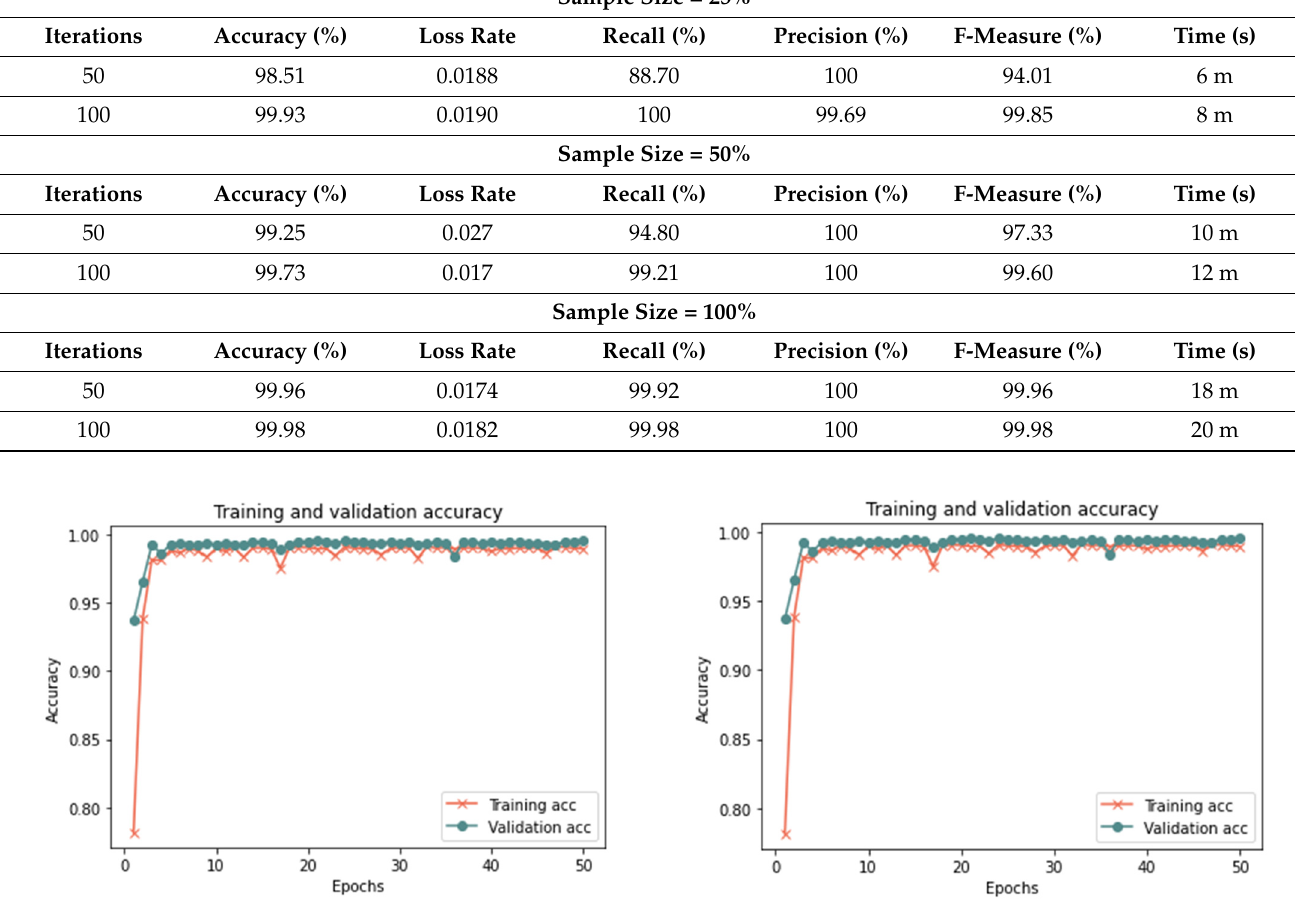
Table 8. Experimental Results of the second scenario.